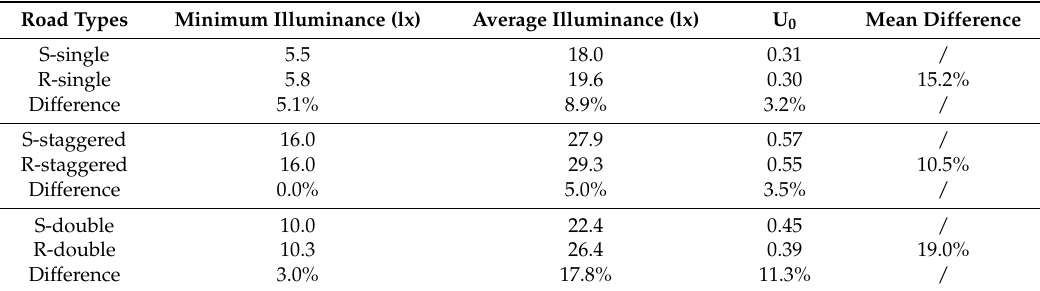
Figure 10. Illuminance reconstructions of simulated road lighting scenes of ( a ) single type ( b ) staggered type, and ( c ) double type in Section 2.1. The measured illuminance points for these road lighting scenes are 10 × 7. The reconstructed illuminances are based on nine feature points. Table 1. Illuminance parameters of simulated and reconstructed road lightings. S represents simulated road lighting, and R represents reconstructed road lighting. The ‘difference’ is the difference of reconstructed and simulated illuminance. The ‘mean difference’ is the mean of difference of reconstructed and simulated illuminance calculated point to point. U 0 is the overall uniformity and is calculated by dividing the minimum and average illuminance.